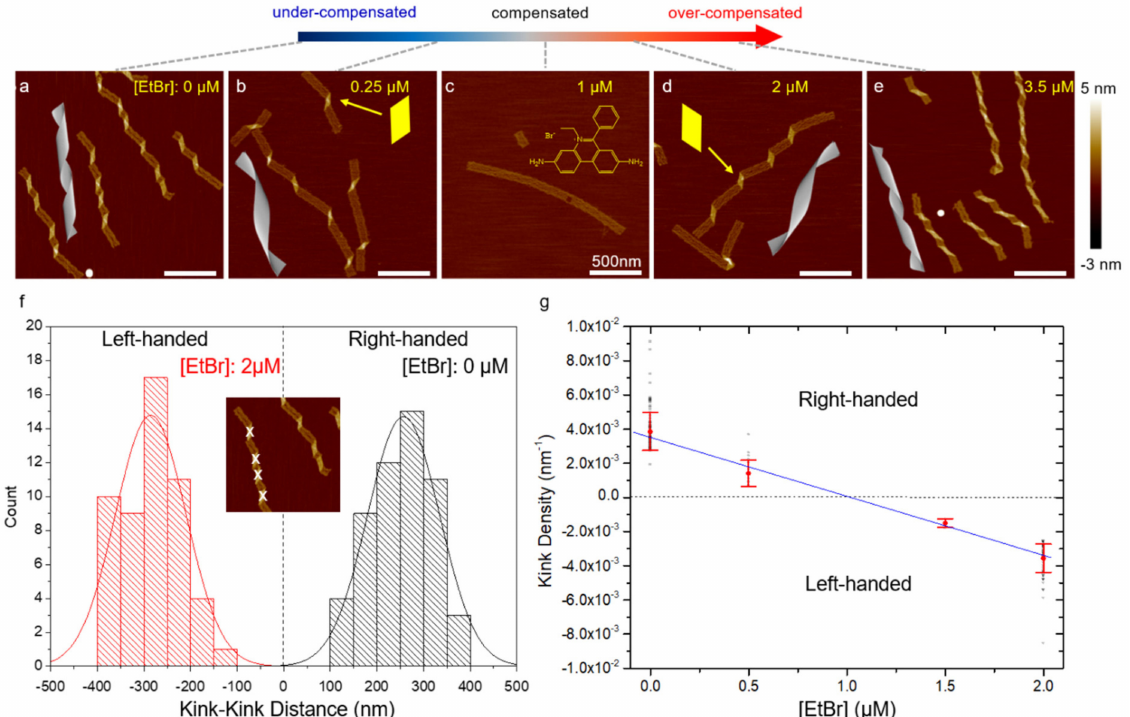
Figure 3. ( a – e ) AFM images of DNA origami ribbons (2 nM) as a function of EtBr concentration from 0 to 3.5 µ M. CanDo simulation results for 10.5 to 10.8 bp/turn are also shown. The handedness of the ribbon twist is represented by the shape of the parallelogram kinks highlighted in ( b , d ). The added EtBr intercalates into DNA duplexes, unwinding the DNA helicity and increasing the helical pitch. As a result, the ribbon conformation gradually changes from a right-handed twist to flat and then to a left-handed curvature. The progressive conformational change is characterized by the kink density. ( f , g ) Statistics of kink density in the ribbons. ( f ) Histogram of kink-kink distance measured under two EtBr concentrations: 0 and 2 µ M. In the inset, the parallelogram-shaped kinks indicating the degree of origami twisting are marked using software ImageJ. Distances between the right-handed and left-handed kinks are marked as positive and negative, respectively. The statistics follow Gaussian functions in general. ( g ) Kink density, defined as the inverse of the distance between neighboring kinks, decreases as EtBr amount increases. The plot suggests that flattening is expected to occur at approximately 1 µ M EtBr, which agrees well with experiment. The inverse of the average distance and the associated standard deviation are denoted by red symbols. The black symbols indicate the scattering of the measurements. The blue line suggests the progressive control of origami conformation using intercalators. (Contents in this figure were previously published. Adapted with permission from [42]. Copyright (2016) American Chemical Society. Further permissions related to the material excerpted should be directed to the